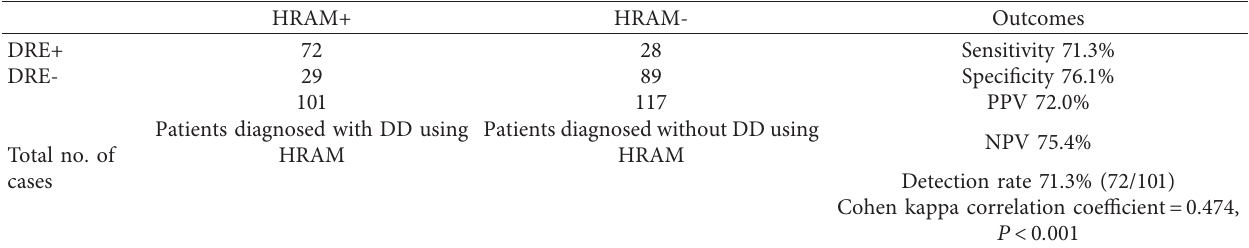
Table 1: Comparison of findings on digital rectal examination with high-resolution anorectal